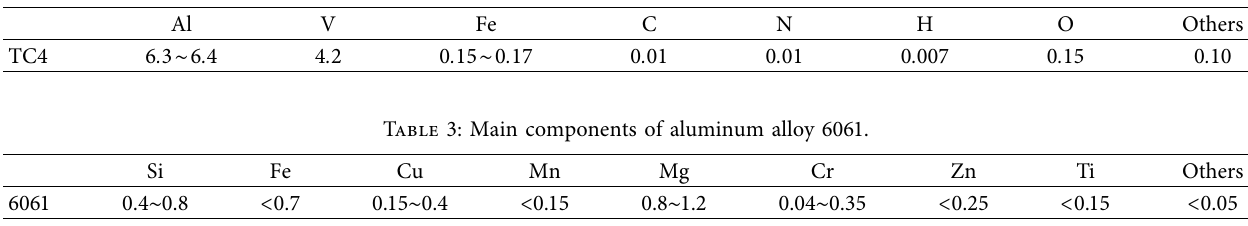
Figure 5: Failure strength and specific strength with the coating rate of Ti. (a) Failure strength of the laminated plate. (b) Specific strength of the laminated plate. Table 2: Main components of titanium alloy TC4.